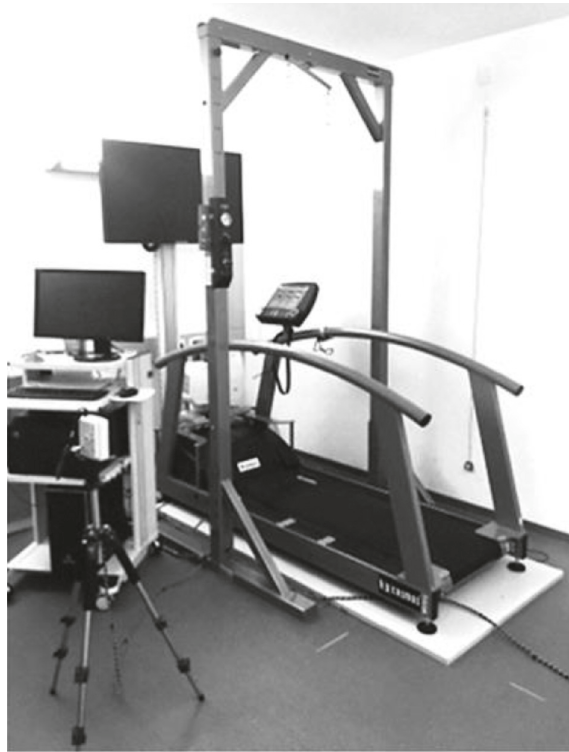
Figure 1: Zebris gait analysis